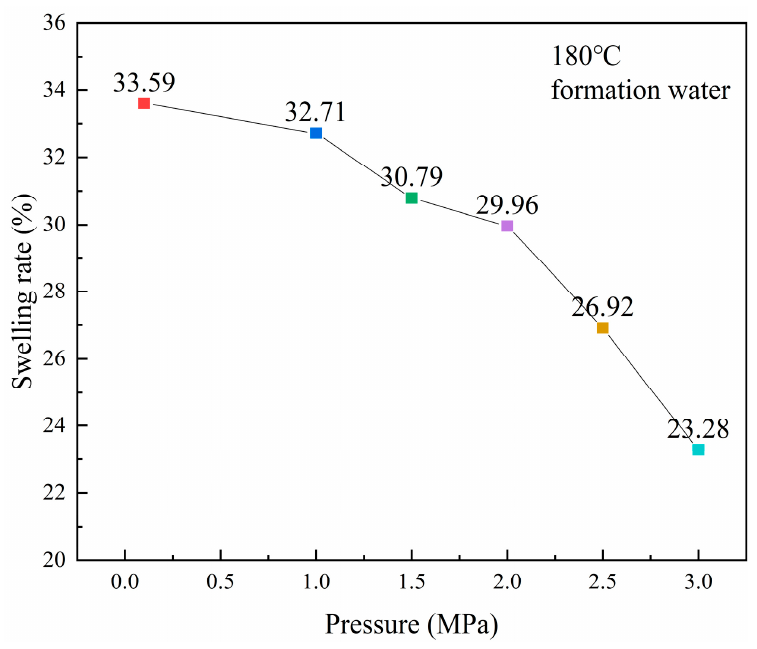
Figure 5. Swelling rate of artificial clay samples with pressure (2#(a)). It can be seen from Figure 5 that as pressure decreases, the swelling rate increases. During the experiment, the temperature is first set to 180 ◦ C and the pressure is set to 3.0 MPa. After the swelling rate stabilized, the pressure was decreased to 2.5 MPa, and then the pressure was reduced to 2.0, 1.5, 1.0, and 0.1 MPa accordingly. On one hand, high pressure promotes water molecules to enter into the clay interlayer, which leads to the promotion of hydration. On the other hand, high pressure has a compaction effect on clay [27]. The second effect is more obvious, so when pressure decreases, the compaction effect decreases and the swelling rate